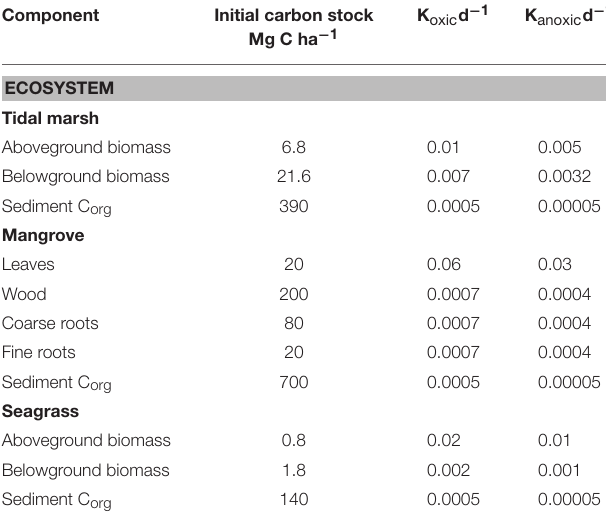
TABLE 1 | Initial organic carbon density in different ecosystem components and the decomposition constants for each component under oxic and anoxic conditions, see text for rate